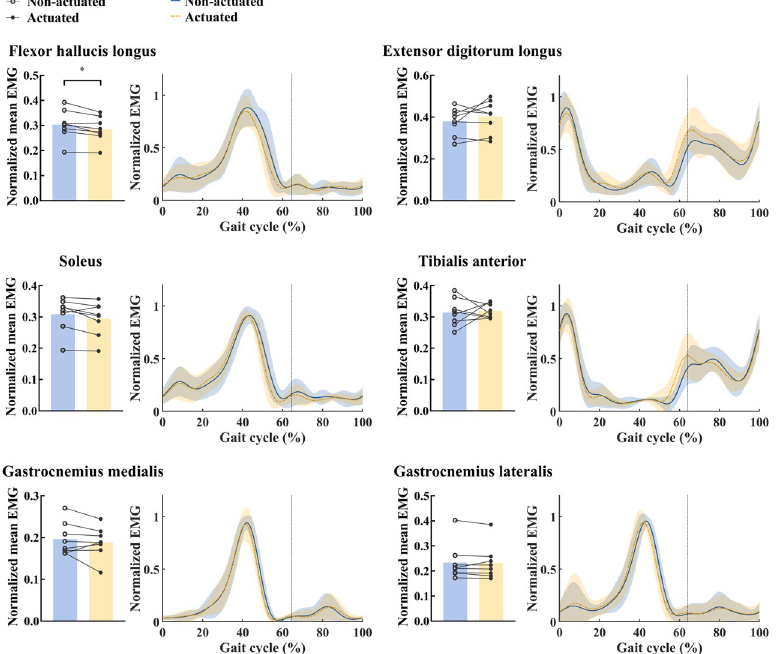
Fig 6. Muscle activities of six muscles over the one gait cycle. Normalized mean EMG (left) and normalized EMG over one gait cycle (right) under actuated and non-actuated conditions are shown for each muscle. Lines link data points from same participant. Curves are averages taken over all participants; shaded regions indicate one standard deviation. The vertical lines indicate the toe-off.